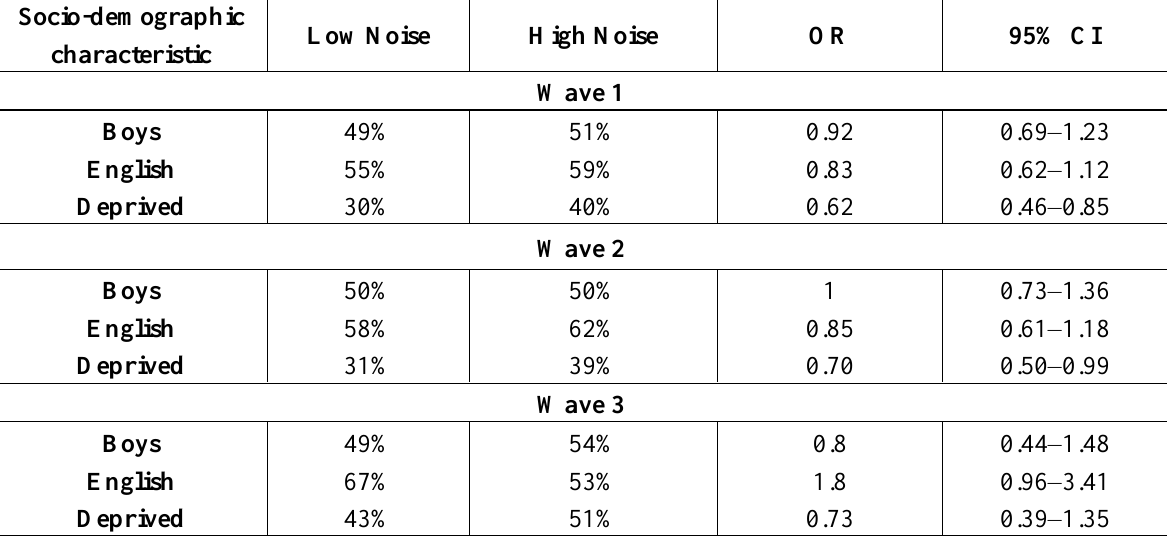
Table 1. The socio-demographic characteristics of the high noise and low noise